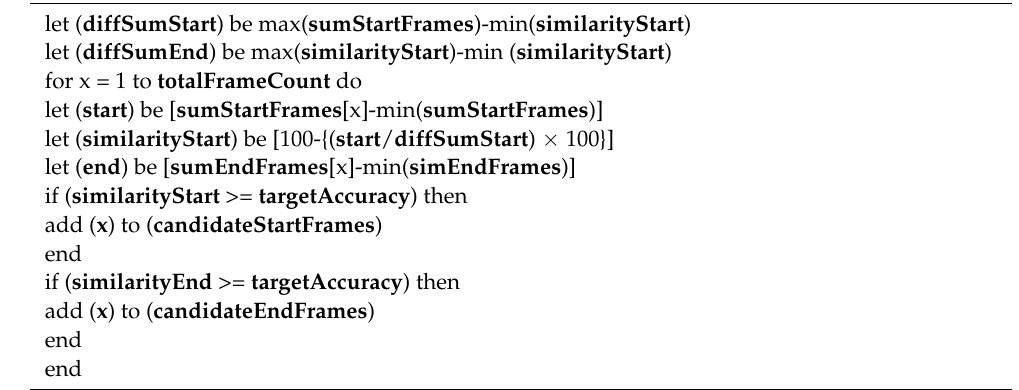
Algorithm 2: Pseudo code for the Candidate Frame Factory module of the TSPDA.